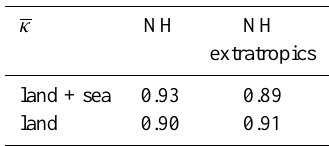
Fig. 4. Intra- and inter-cluster coherence spectrum (smoothed). The gray areas mark, from dark to light gray, the 90%, 95%, and 99% significance level. The vertical dashed line indicates the frequency threshold below which reconstructions are compared for clustering. Table 4. Coherence between target areas as simulated by ECHO-G